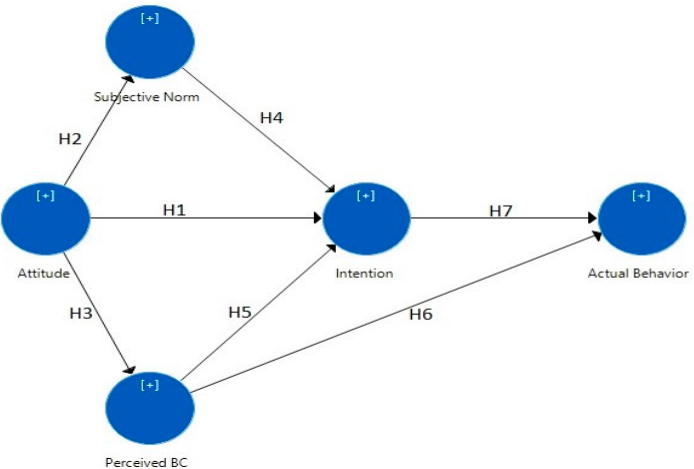
Figure 1. Research model with latent variables and hypotheses adapted from Icek Ajzen theory of planned behavior and applied to the formalization of subsequent land transactions.